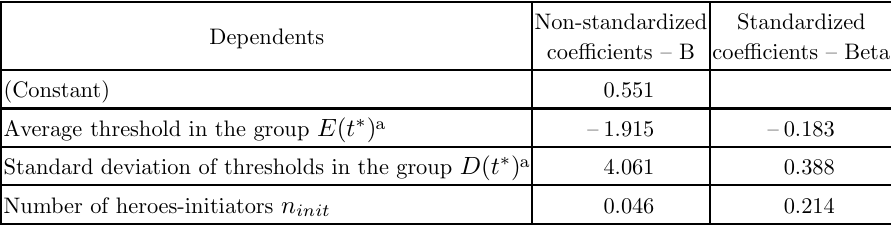
Linear regression coefficients. Dependent: range of diffusion (heterogeneous groups, N = 36000